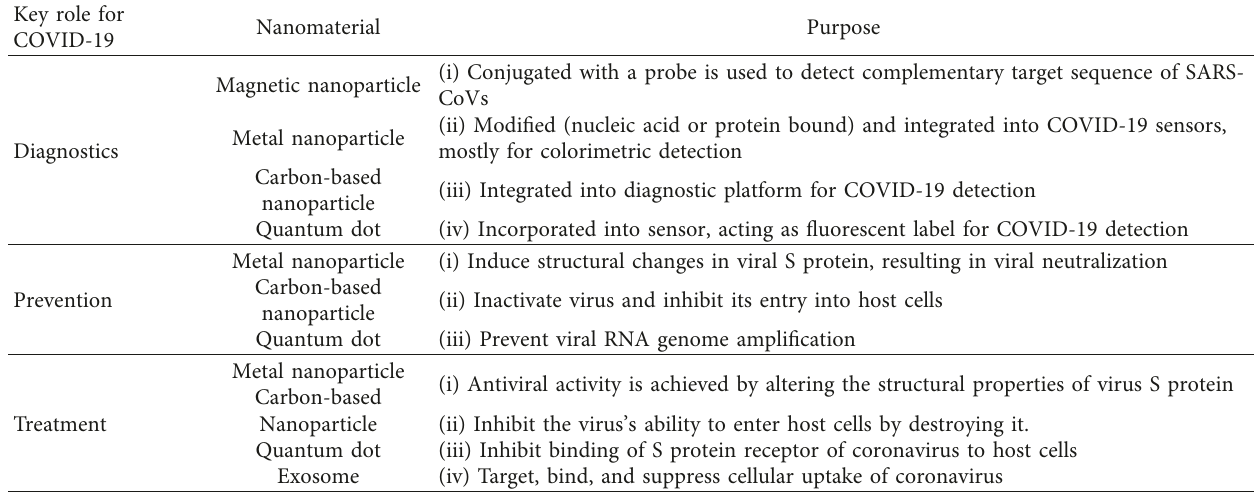
Table 1: Summary of the role of nanomaterials for COVID-19. Key role